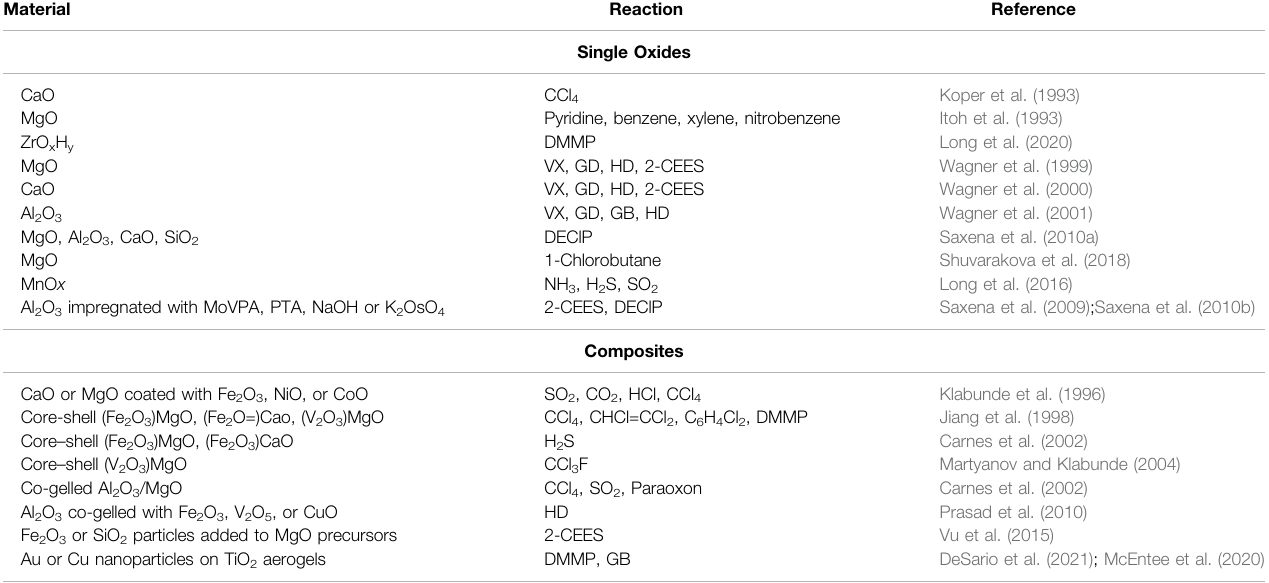
TABLE 1 | Summary of key oxide aerogel compositions and the reactions evaluated. Material